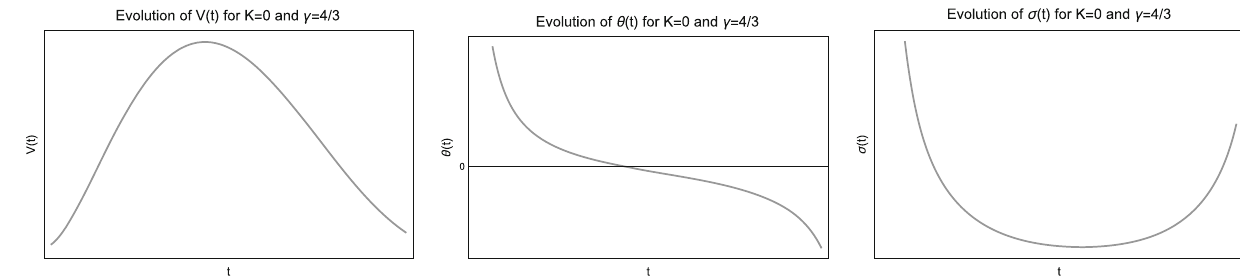
Fig. 1 Numerical simulation of the total volume, V ( t ) , volume expansion rate, θ ( t ) , and shear anisotropy scalar, σ ( t ), for the graviational (cid:9) (cid:9) (cid:9) > ρ (cid:9) ρ = 0, which corresponds to a Bianchi I universe equations when γ = 4 , g 0 m 0 and K 3 evolution of the scale factors 1 a ( t ) and b ( t ) . Moreover, the spatial curvature K of the2-dimensional lineelement ds 2 ( (( y − y ) 2 + ( z − z ) 2 ) + c ) − 2 ( dy 2 + dz 2 ) is ( c 1 0 0 2